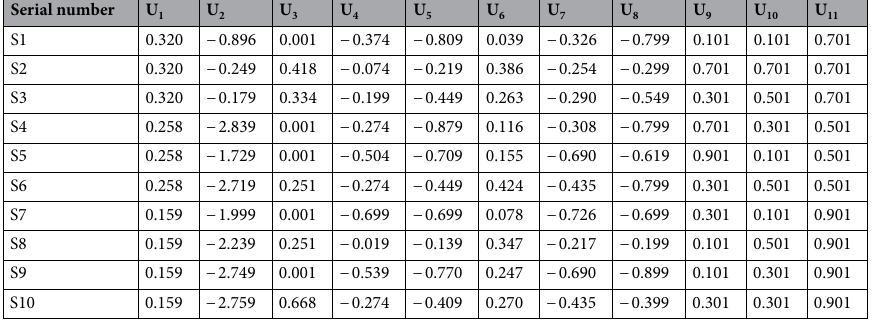
Table 8. Dimensionless data.